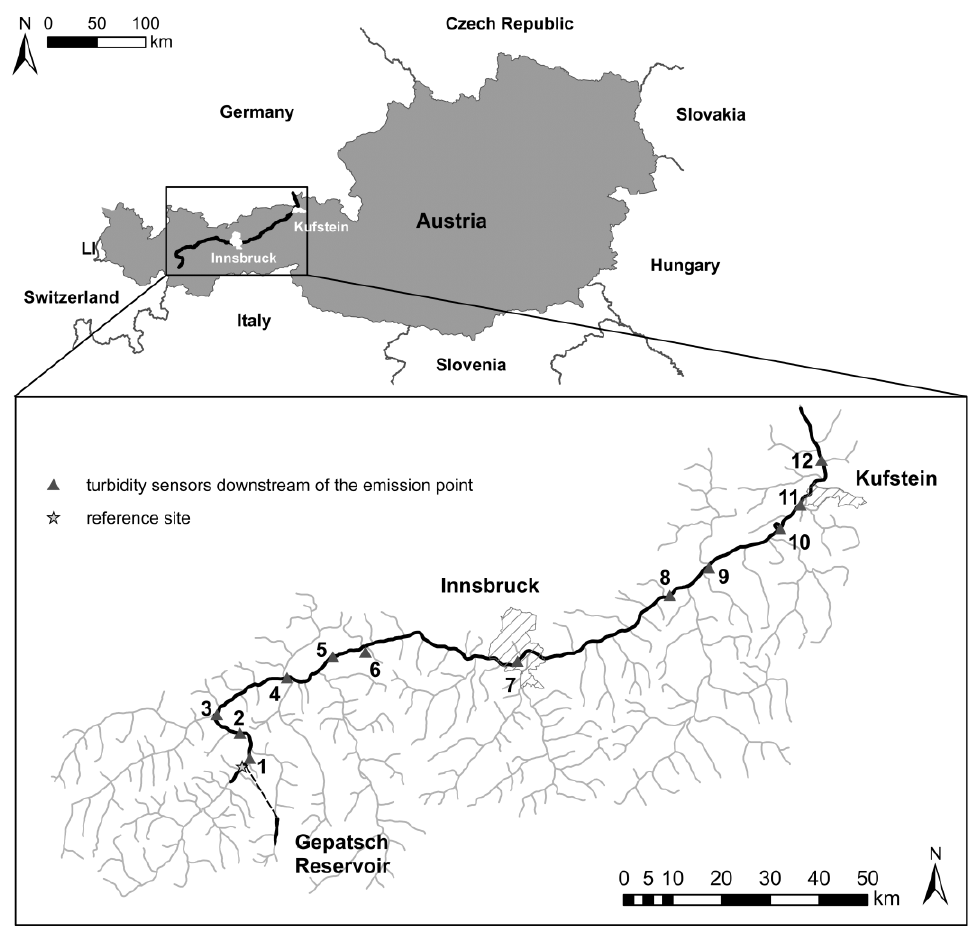
Figure 1. Austrian map with the sampled Inn River highlighted and reach scale sampling stretch of the Inn River from the reference site Ried (upstream boundary) to the German border (downstream boundary). The penstock from the reservoir to the power station in Prutz is dotted (the monitoring station in the tailrace channel is not indicated). The triangles indicate continuous turbidity monitoring stations (at gauging stations). 1 = Prutz Entbruck, 2 = Fließ Neuer Zoll, 3 = Landeck− Perjen, 4 = Karrösten Königskapelle, 5 = Haiming Magerbach, 6 = tailrace channel HPP Silz, 7 = Innsbruck Arthur Haidl Promenade, 8 = Rotholz, 9 = Rattenberg, 10 = Kirchbichl, 11 = Langkampfen, and 12 = Oberaudorf.